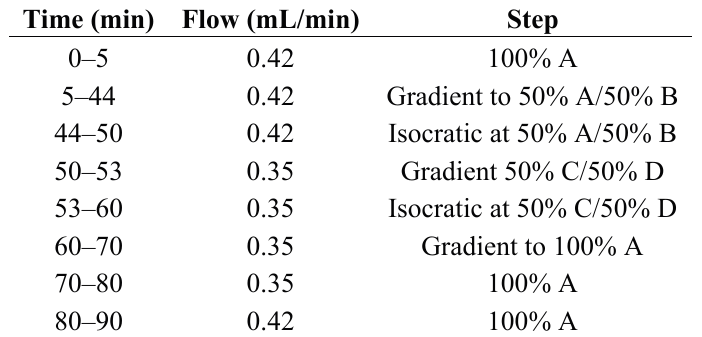
Table 3. HPAEC-PAD gradient program for separating fructans and simple sugars a